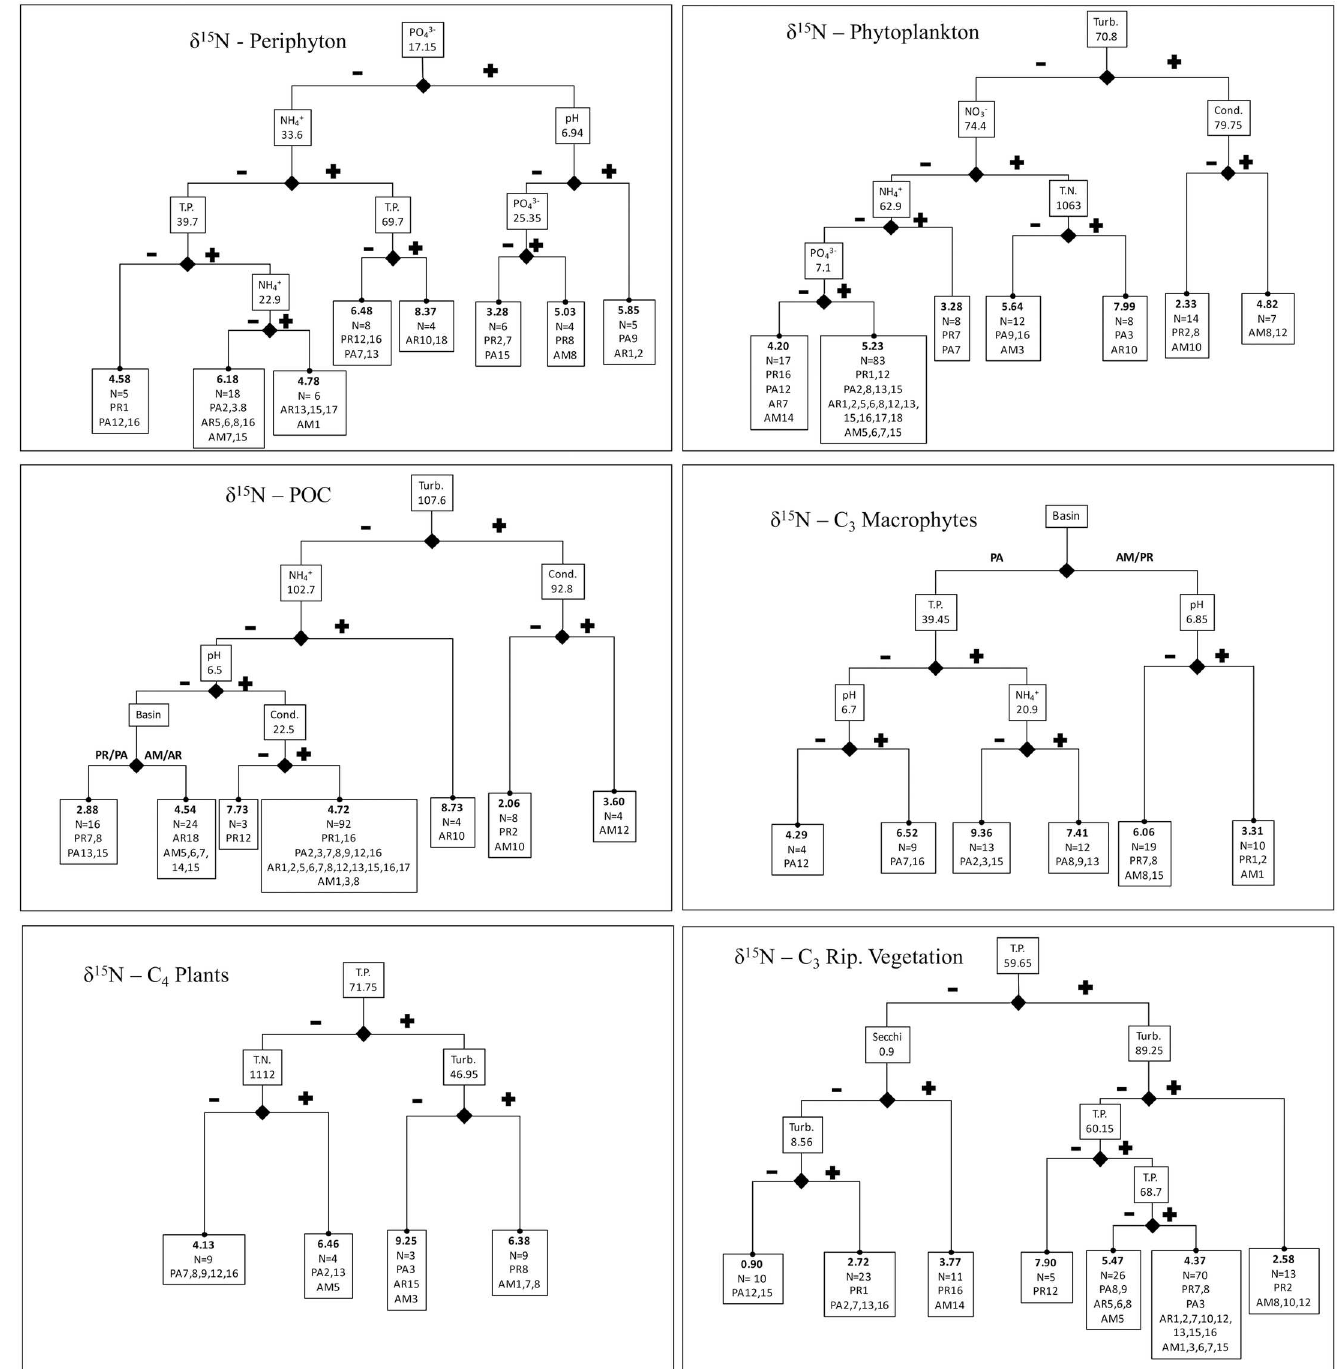
Fig 4. Regression trees predicting δ 15 N for each carbon source. Splits are identifiedby boxes on branches with the corresponding parameter and value, and terminal nodesare identifiedby boxes including the mean value for the responsevariable(i.e. δ 15 N) as well as the numberof samples and samplinglocationsincludedin the node. Plus and minus signs or basin abbreviations designatethe level of parameter to the left or right of a split (e.g. TP less than or greater than 59.65 for the first split for riparianvegetation).